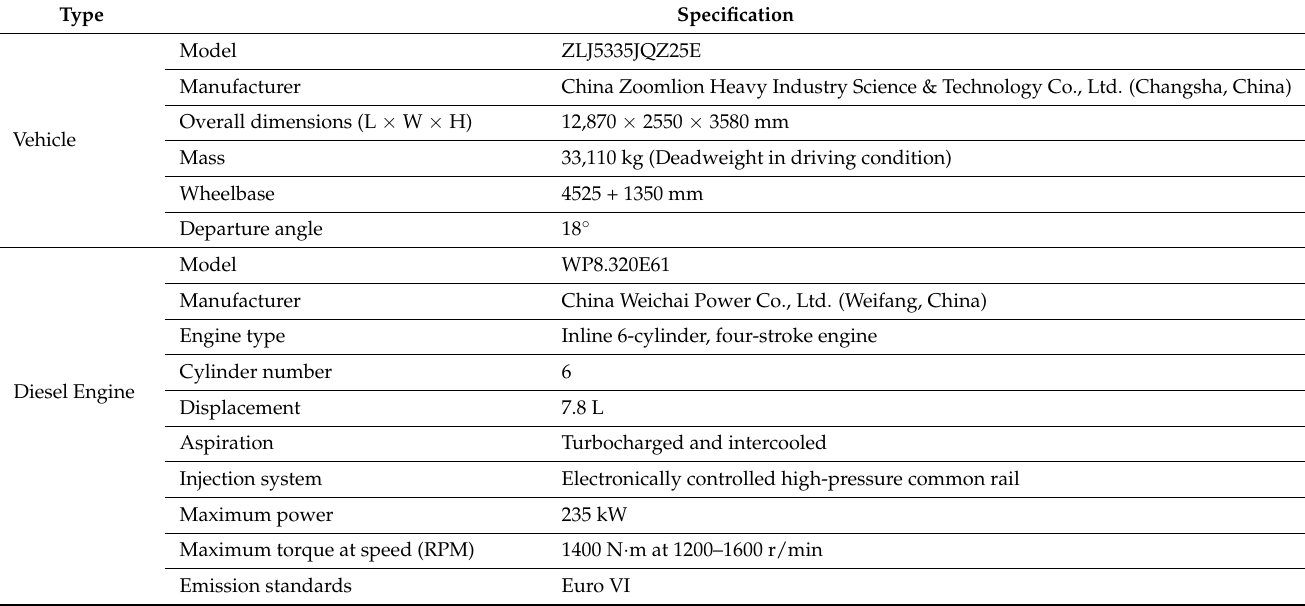
Table 1. Specifications of test